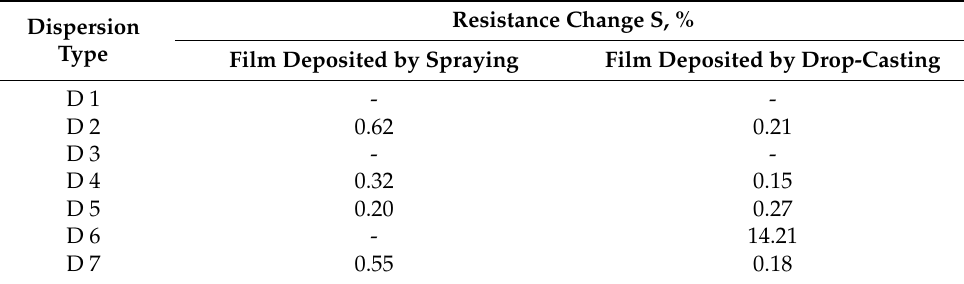
Table 3. Summary of the resistance change (S) value (in %) of the sensitive